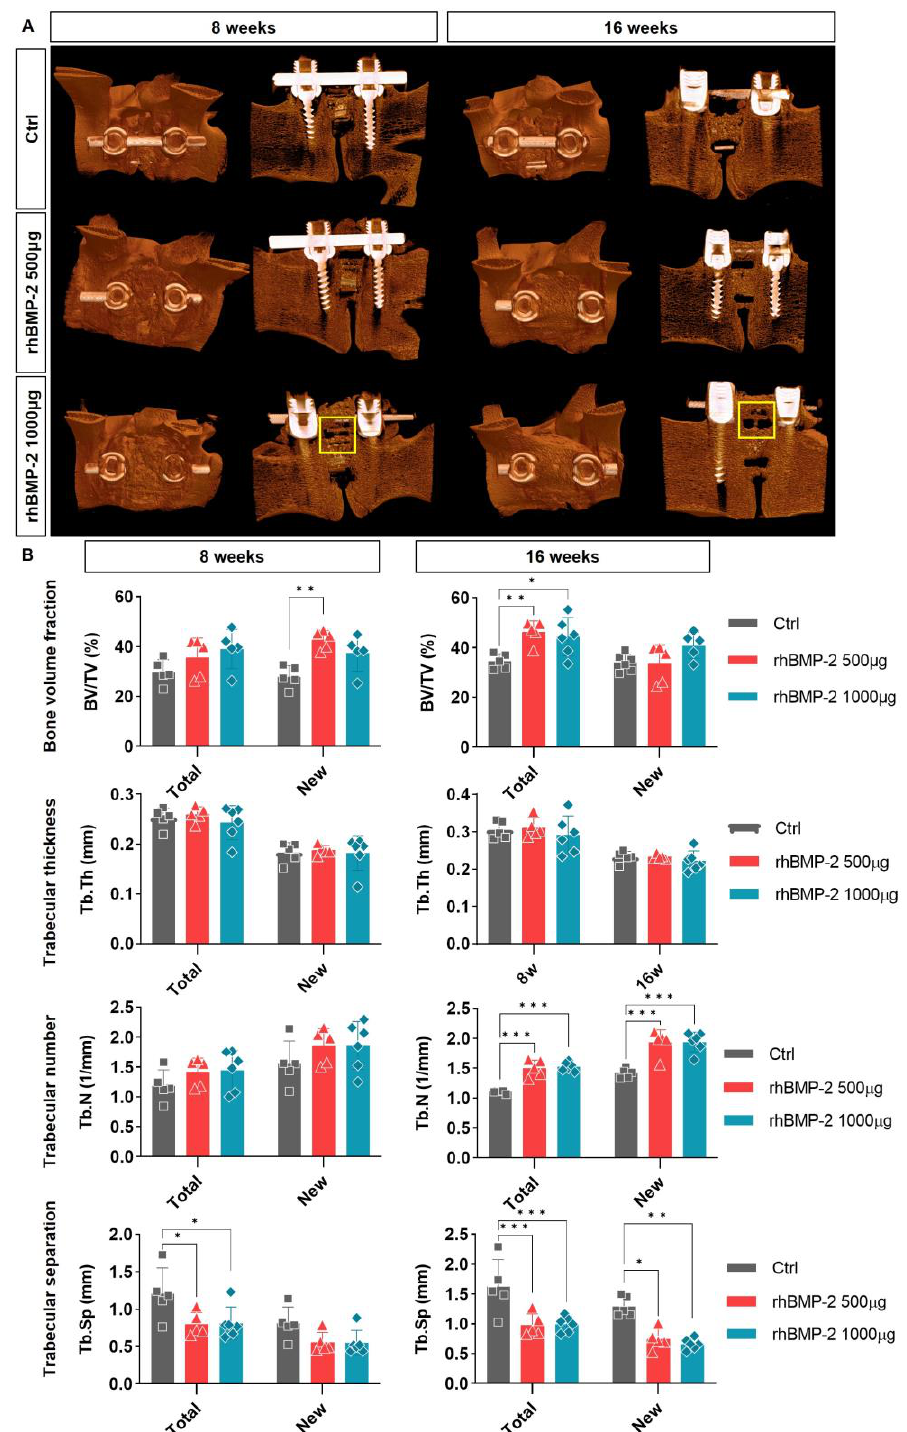
Figure 3. Trabecular bone analysis of 3-dimensional micro-CT images. ( A ) A 3D-reconstruction image of spine OLIF using micro-CT. ( B ) Trabecular bone analysis on a 3D-micro-CT image. The bone volume fraction, trabecular thickness, number, and separation were analyzed for total and new bone. In total and new bone, the bone volume fraction and trabecular number increased in proportion to the presence of rhBMP-2. However, fiber strain segregation showed an inverse pattern, decreasing with higher rhBMP-2 concentrations. However, significant differences were not found according to the concentration of rhBMP-2, and the low-rhBMP2-concentration group tended to show higher values for the bone volume fraction. * p < 0.05, ** p < 0.01, and *** p < 0.001 indicate statistically significant differences.